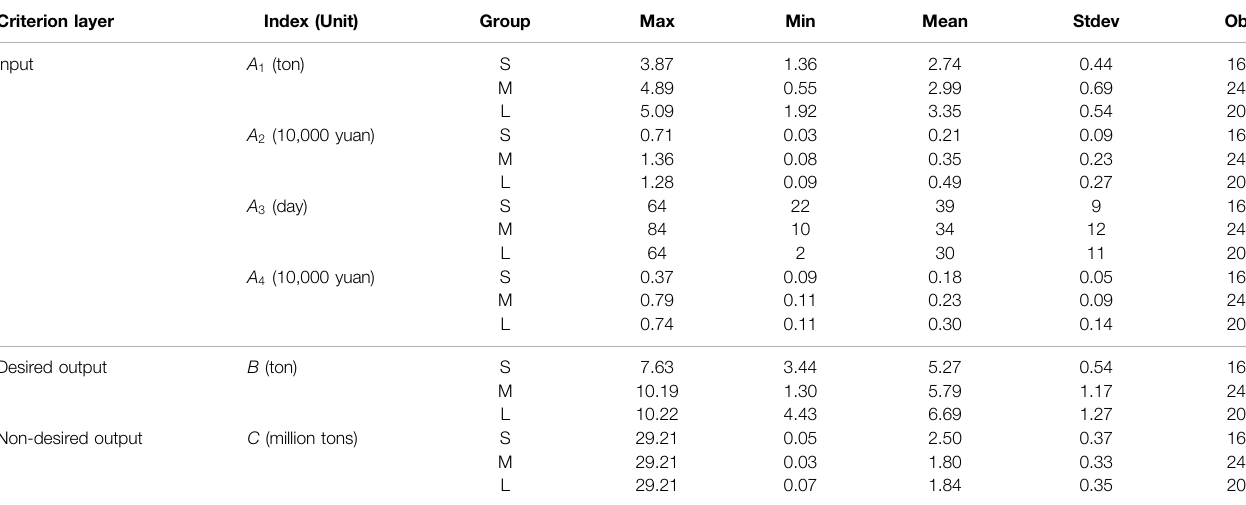
TABLE 2 | Descriptive statistics of a variable. Criterion